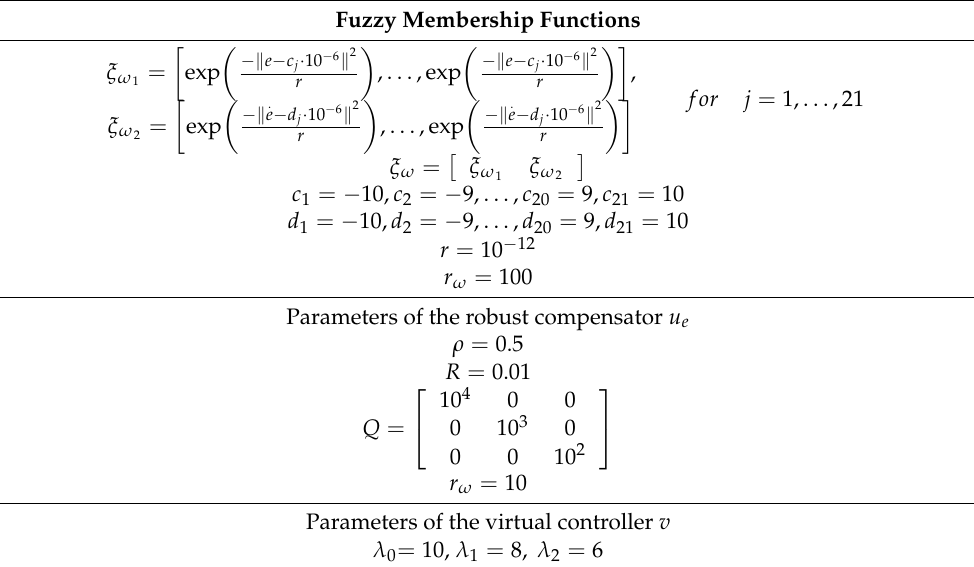
Table 2. Fuzzy membership functions and control parameters of this proposed